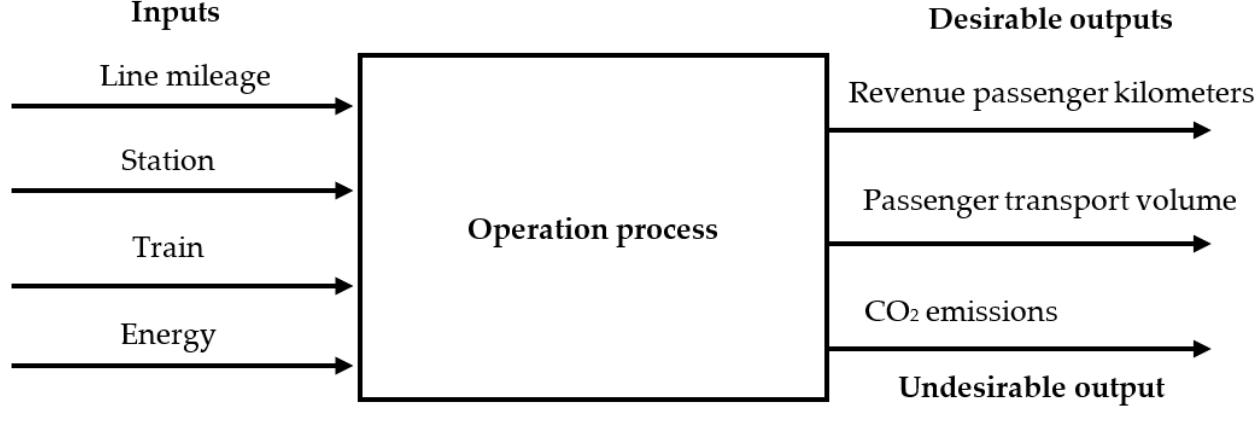
Figure 1. The operation process of a URT system.